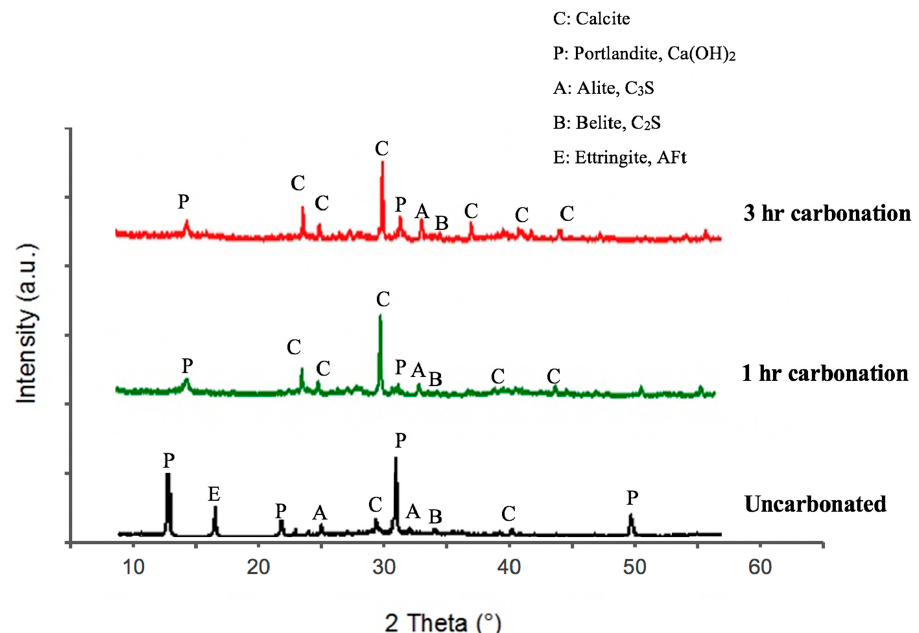
Figure 8. XRD patterns of uncarbonated and carbonated brick specimens.